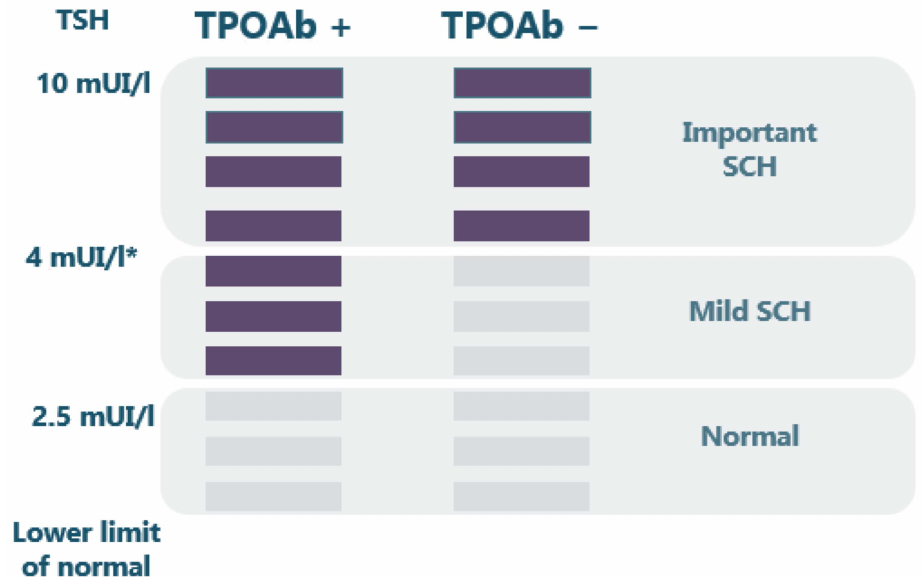
Figure 2. SCH approach according to TSH value and the presence of thyroid autoimmunity—filled violet rectangles suggest treatment while grey rectangles suggest no need for treatment; SCH—subclinical hypothyroidism; TSH—thyroid stimulating hormone; TPOAb—thyroid perox- idase antibodies; * —or upper limit of normal for